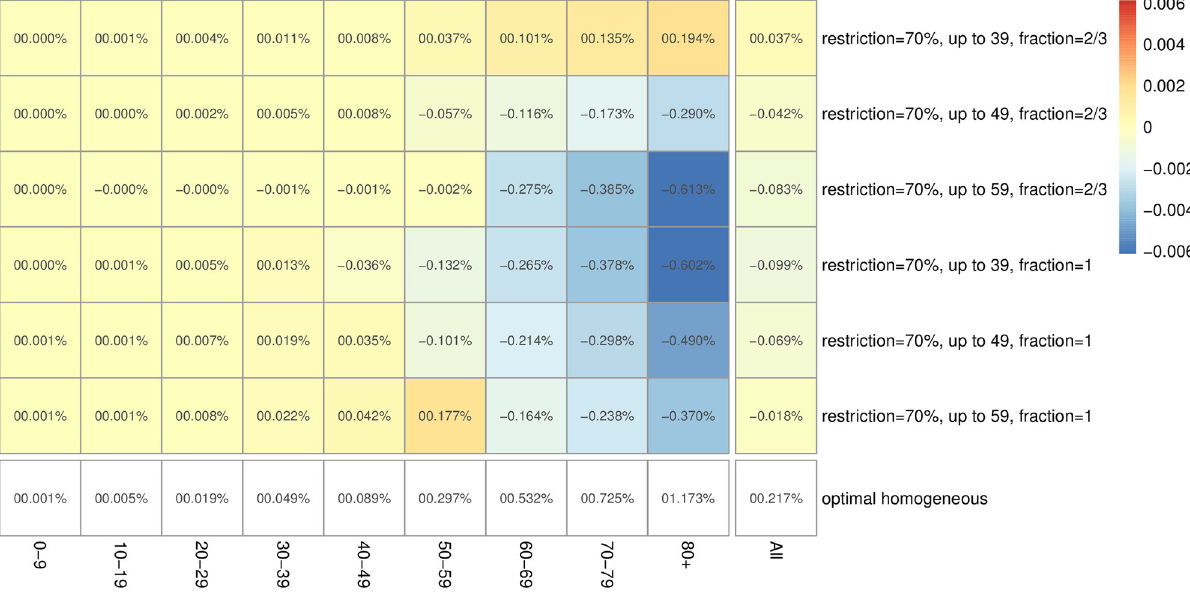
Fig 7. Impact on mortalities by age group (in groups of 10 years). The bottom row of this table shows mortalities in each age group for the optimum homogeneous mitigations scenario, as a fraction of the total population of the age group. Note that this is not the IFR. Each other row corresponds to a scenario discussed in Section 4.2. The values in the cells in these rows show the difference in the mortality rate for each age group for the given scenario, compared with the optimum homogeneous scenario. https://doi.org/10.1371/journal.pone.0236237.g007 by the uniformity of the Peron-Frobenius eigenvector) which leads to the expectation of a lower attack rate. For example, in scenarios where reduced transmissibility and infectiousness apply to everyone under 20, hetereogeneity would decrease and IFR and total mortality would move in the same direction.